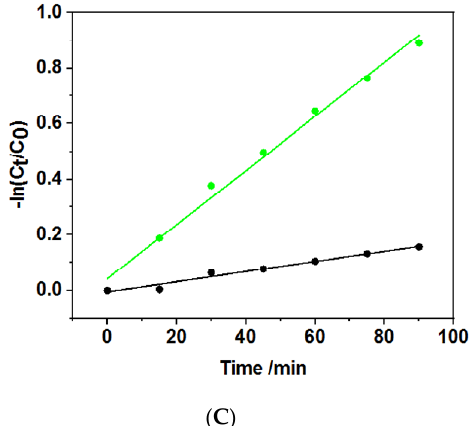
Figure 8. Kinetics analysis of degradation efficiency of MB: ( A ) plot of C t / C 0 vs. irradiation time; ( B ) plot of (C 0 − C t ) / C 0 × 100 vs. irradiation time; ( C ) plot of ln(C 0 / C t ) vs. irradiation time, respectively for the MB degradation in the presence of CdS nanoparticles (green) and without CdS nanoparticles (black).